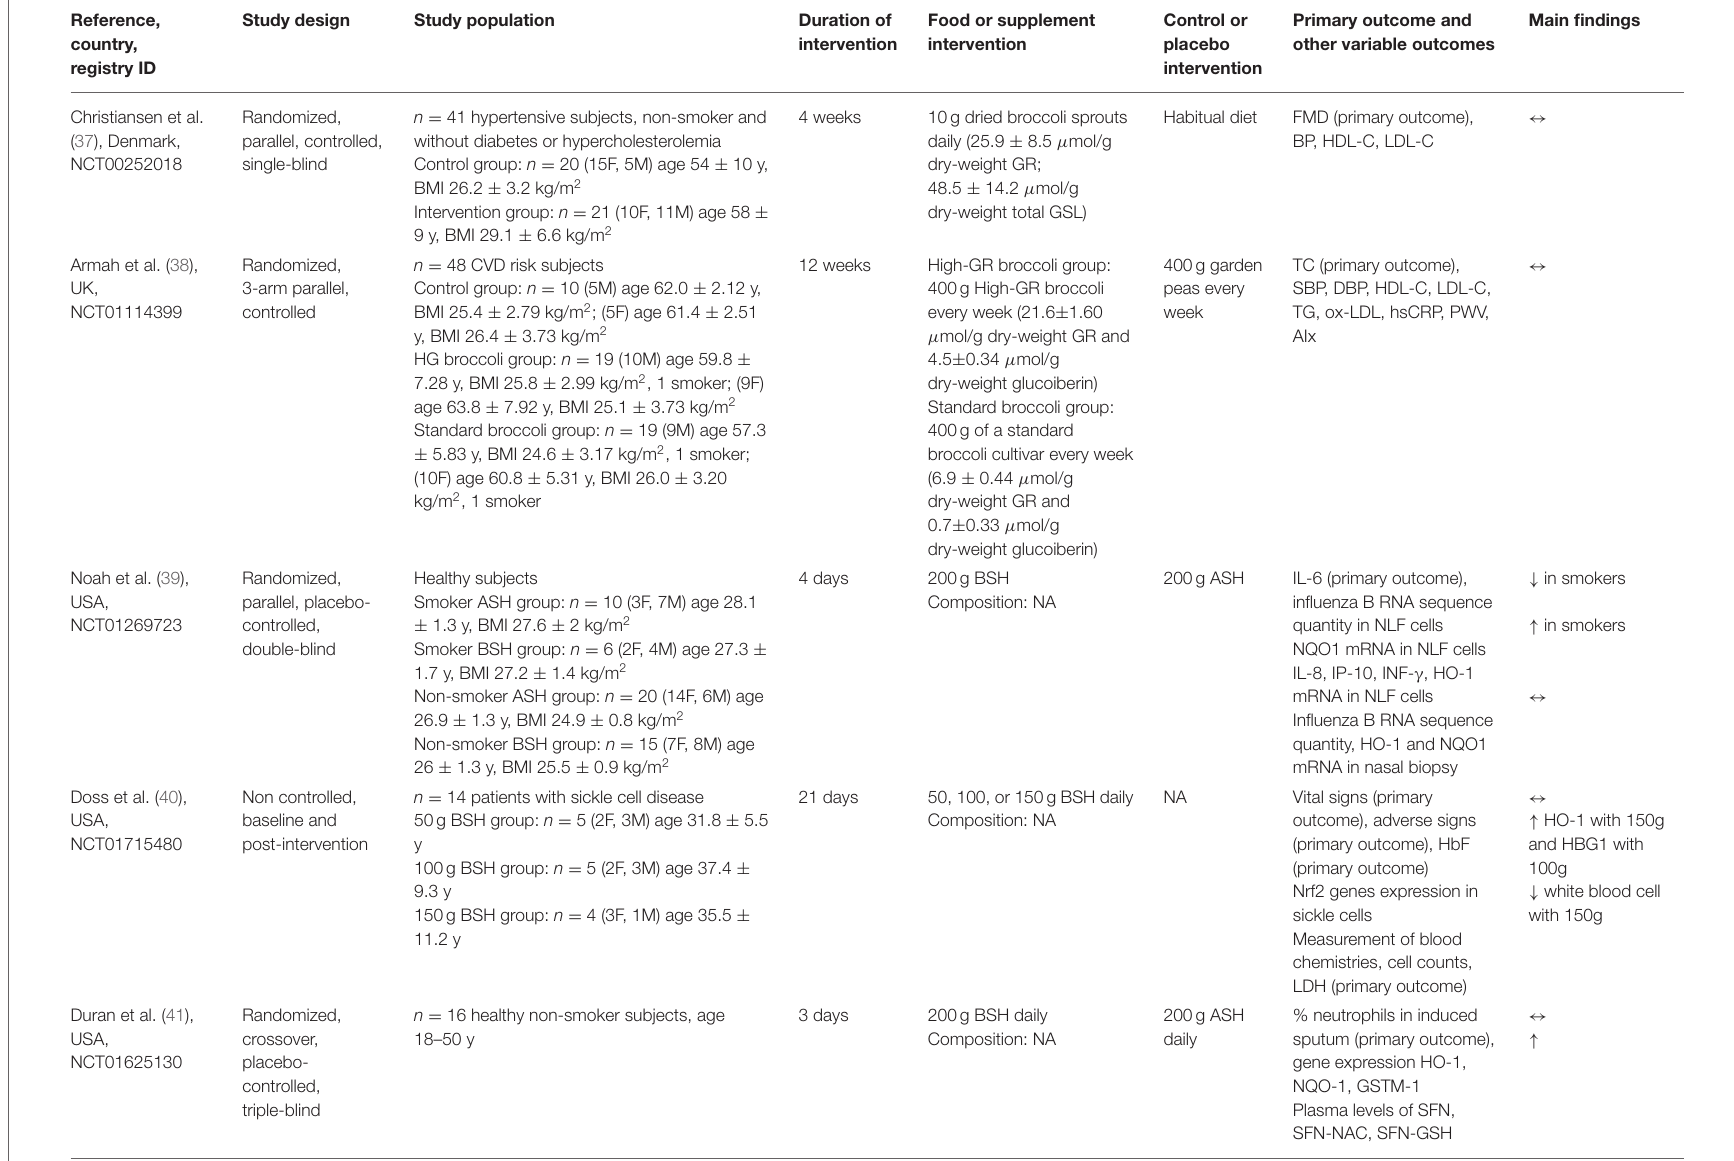
TABLE 3 | Characteristics and findings of publications associated with registered trials on GSL-rich